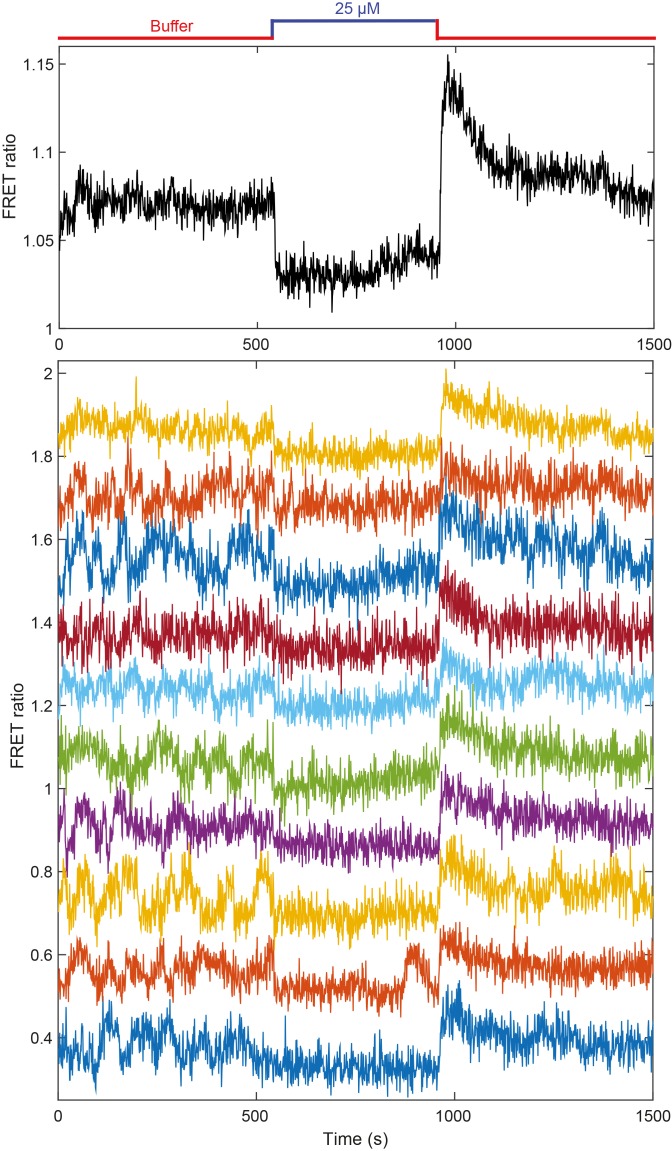
Additional FRET measurement for CheR+CheB+ cells.Population averaged FRET ratio (top) and corresponding single cell FRET ratios (bottom), for a typical FRET experiment, with adaptation-proficient strain expressing TarQEQE as the sole receptor. Cells initially adapted in buffer were stimulated with 25 µM MeAsp, before returning to buffer. FRET ratios for individual cells have been shifted to facilitate visualization.